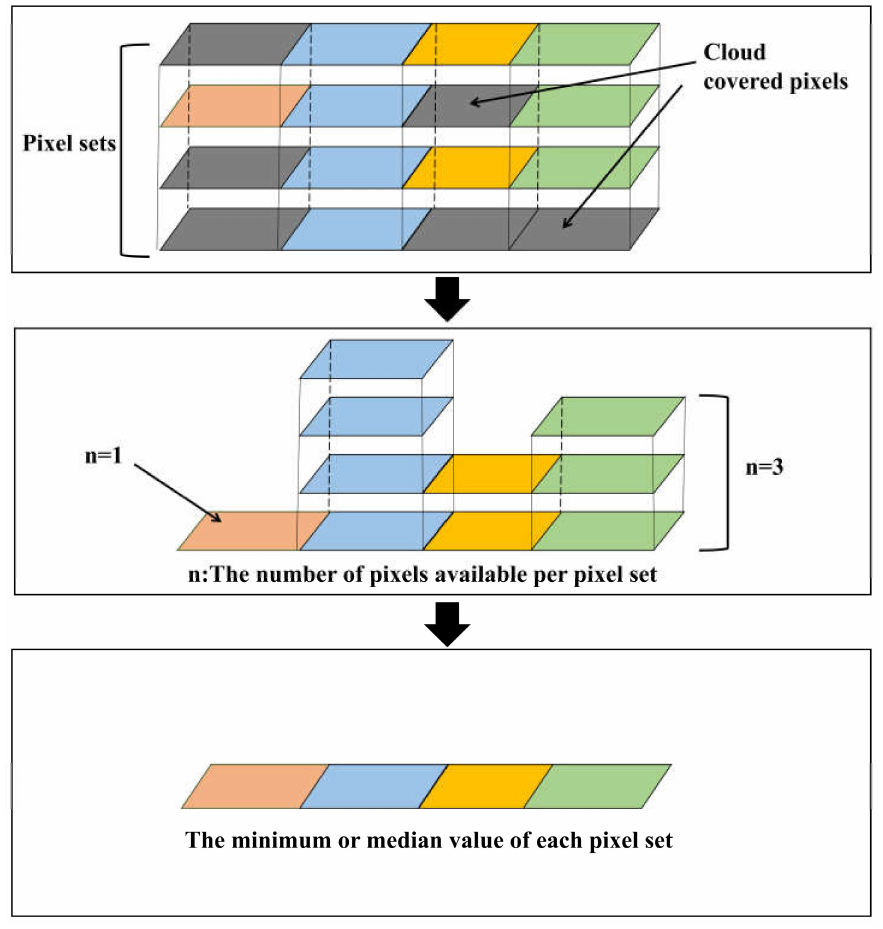
Figure 3. Image synthesis